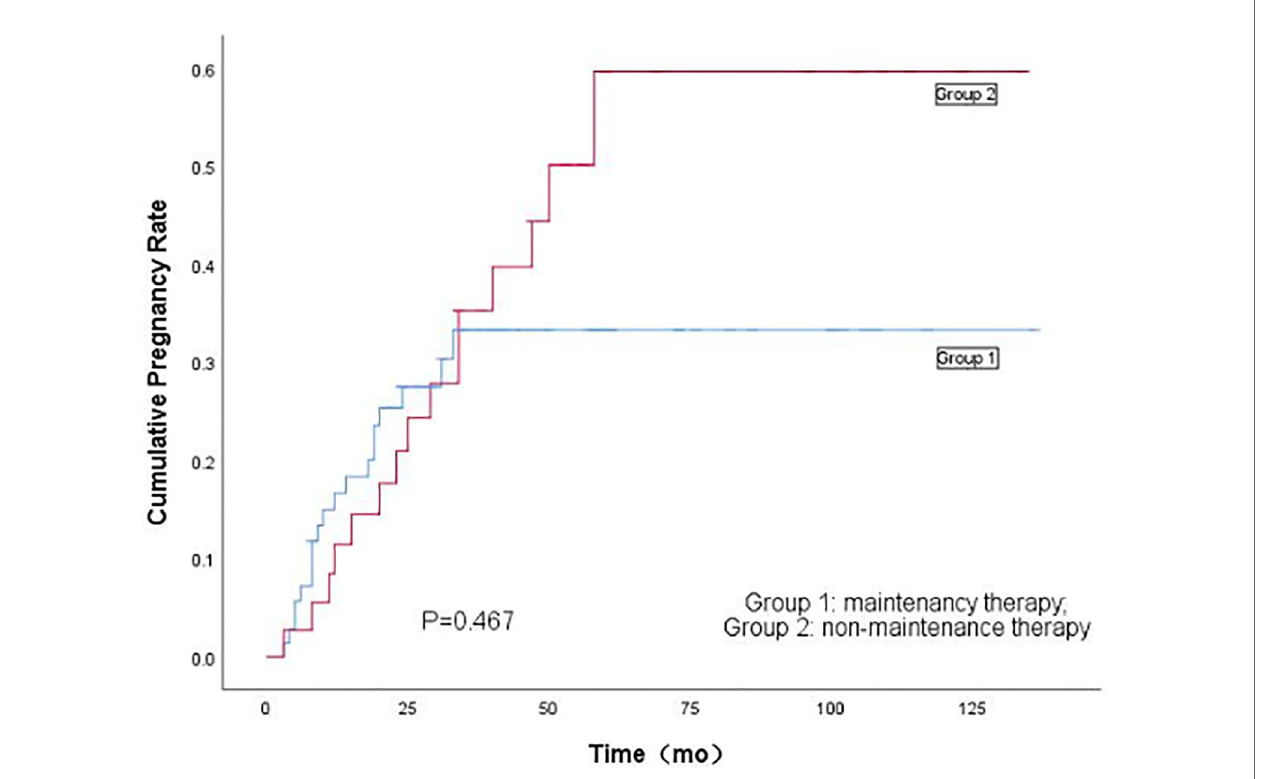
FIGURE 5 | Kaplan-Meier's analysis of the effect of maintenance therapy on cumulative pregnancy rate Between Group 1 and Group